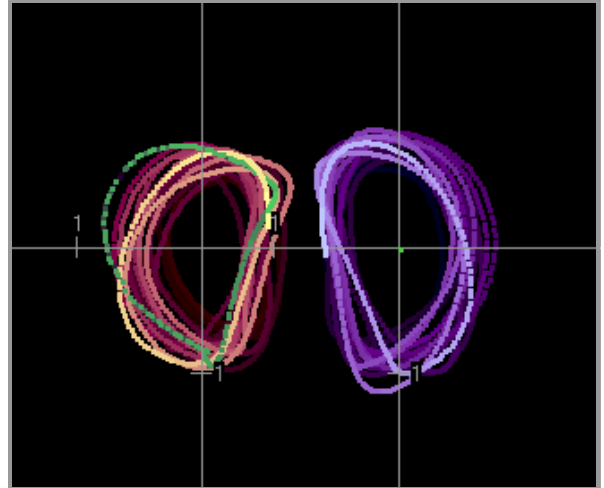
Figure 9. Position of the left and right wrists projected on the selected plane (it is parallel to the plane defined by the shoulder blades and tailbone). Continuously changing colors of trajectories are related to time flow; the brightest colors correspond to the latest signal probes. The units on the axes refer to 0.2